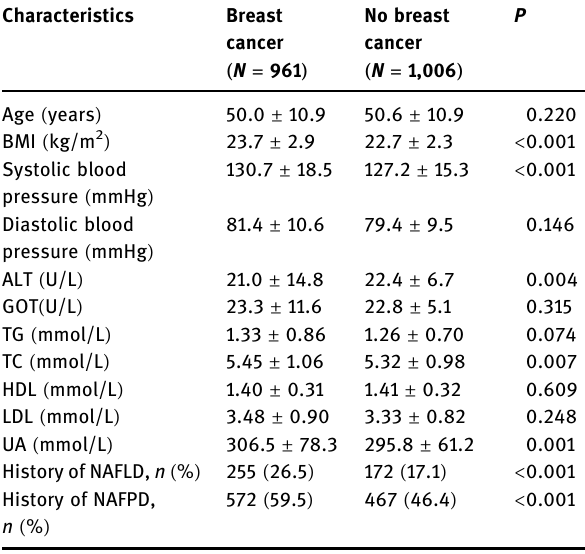
Table 1: General characteristics of patients with or without breast cancer